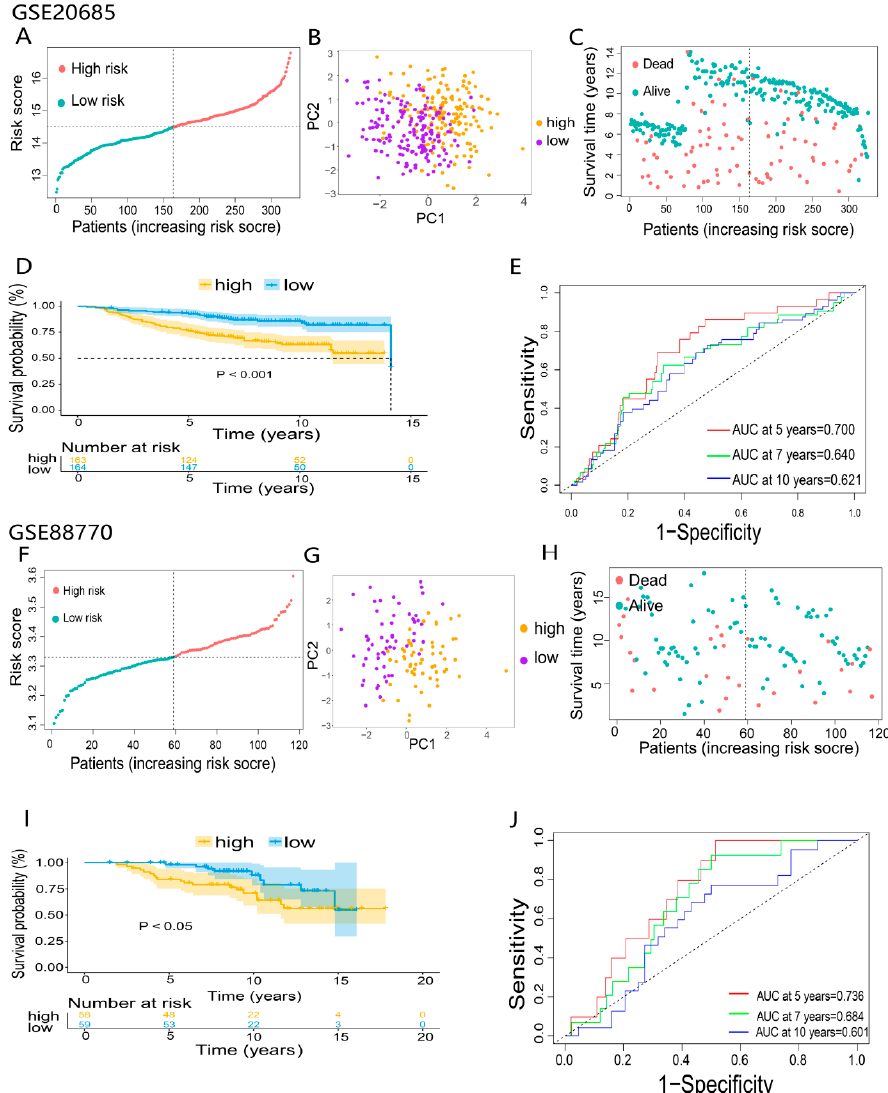
Figure 5. Validation of 6-DEDGs feature prognostic models: ( A , F ) classification of patients in the GEO validation cohorts based on the median risk score of the TCGA cohort; ( B , C , G,H ) principal component analysis (PCA) of 2 GEO validation cohorts; ( D , I ) the overall survival and survival status analysis of 2 GEO validation cohorts; ( E , J ) the time-dependent receiver operating characteristic (ROC) of 2 GEO validation